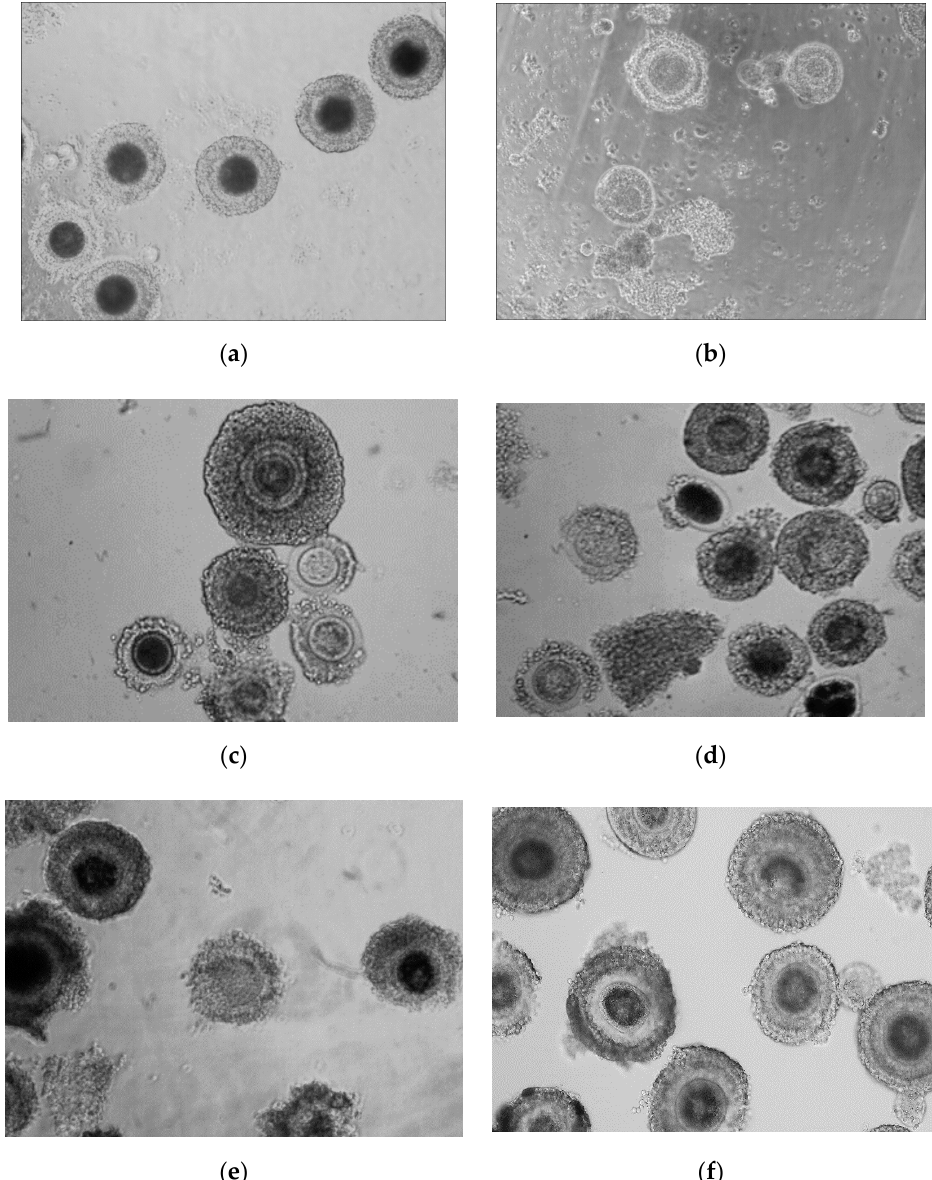
Figure 2. Oocytes of wild felids; ( a ) oocytes with dark cytoplasm from adult serval, ( b ) oocytes with light cytoplasm from adult serval, ( c ) oocytes from adult Pallas’s cats, ( d ) oocytes from prepubertal Pallas’s cats, ( e ) oocytes from adult lynx, ( f ) oocytes from prepubertal lynx.